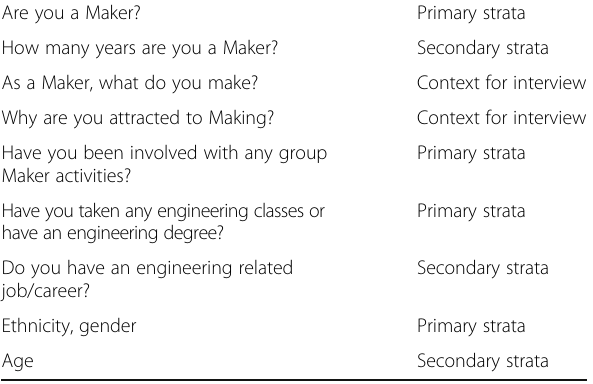
Table 5 Screening questionnaire questions